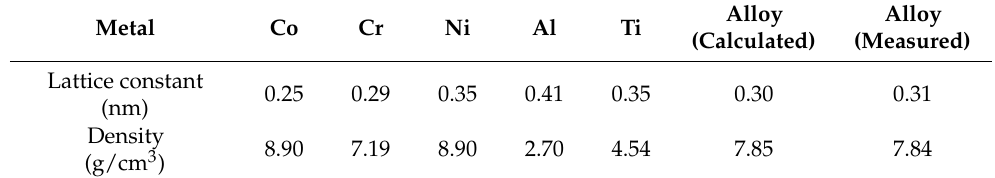
Table 4. Densities and lattice constants of the component metals of Co 32 Cr 28 Ni 32 . 94 Al 4 . 06 Ti 3 .